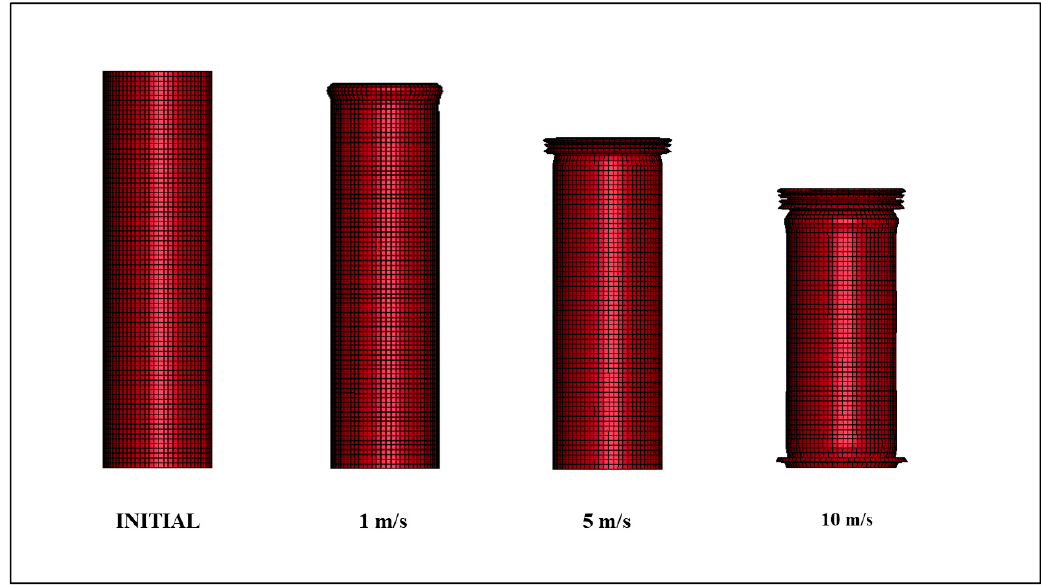
Figure 20. Comparison of the initial condition of the battery model with the maximum deformation of the battery model under loading speeds of 1, 5, and 10 m/s.